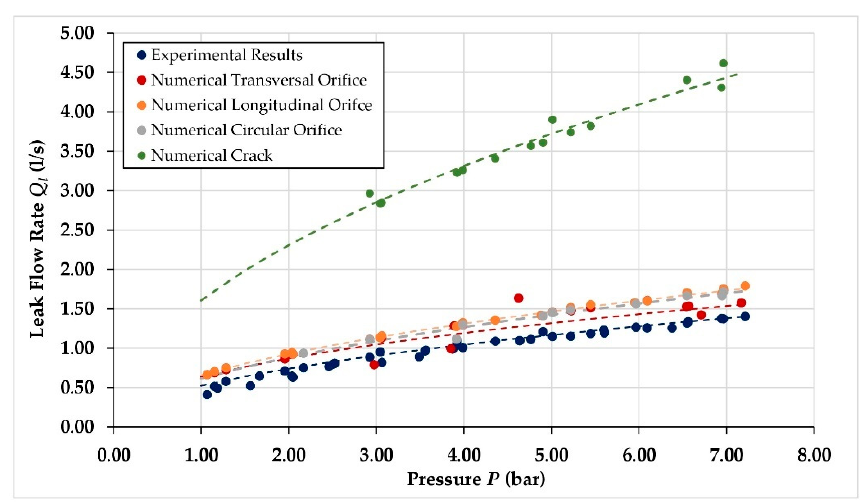
Figure 9. Comparison between experimental and numerical results.